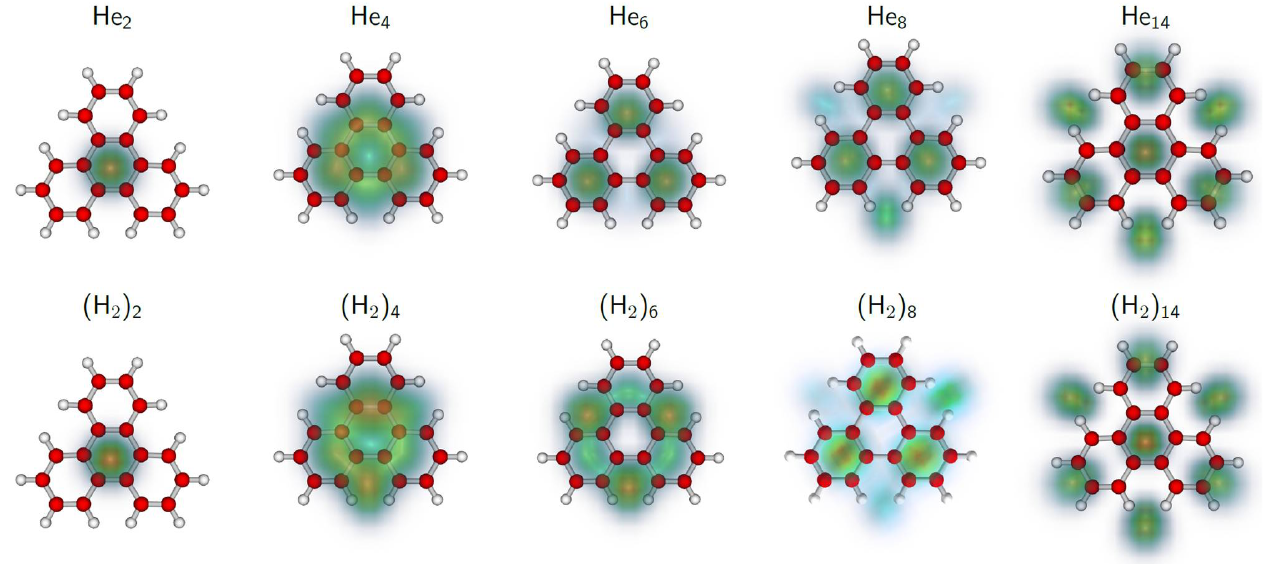
Figure 3. Selected structures of He n TPL + and (H 2 ) n TPL + clusters with n = 2, 4, 6, 8, and 14. For each size, the helium and H 2 densities obtained from the PIMD simulations are superimposed on the structure of TPL + .